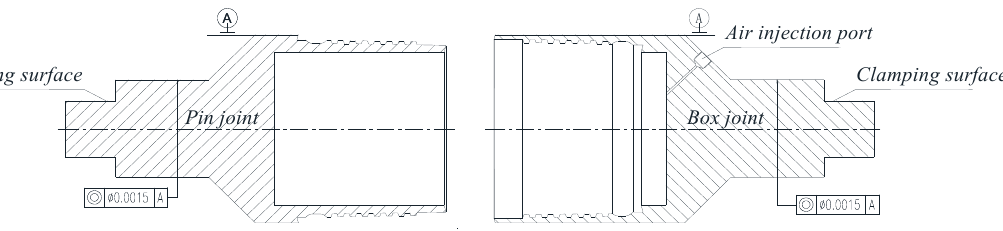
Figure 17. Tensile test platform.